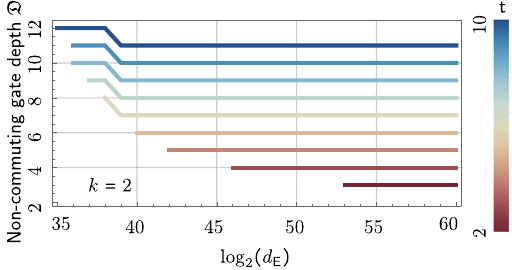
Fig. 5 Scaling of the non-commuting gate depth of the approximate unitary design by Winter et al. 14 for a 2-step process on a single qubit to Markovianize with respect to environment size. Scaling of the non- commuting gate depth D , given by the minimum amount of alternate repetitions ℓ of the two kinds of random two-qubit diagonal gates within the unitary W ‘ , plotted against the environment qubits n E = log 2 ( d E ), to generate an ϵ = 10 − 12 approximate unitary t -design for 2 ≤ t ≤ 10. This is such that for a single-qubit system undergoing a process with k = 2 timesteps, the probability P t for the non-Markovianity N exceeding 0.1 is ϵ less or equal than 0.01, i.e. P t ½ N (cid:10) 0 : 1 (cid:6) (cid:11) B (cid:11) 0 : ϵ